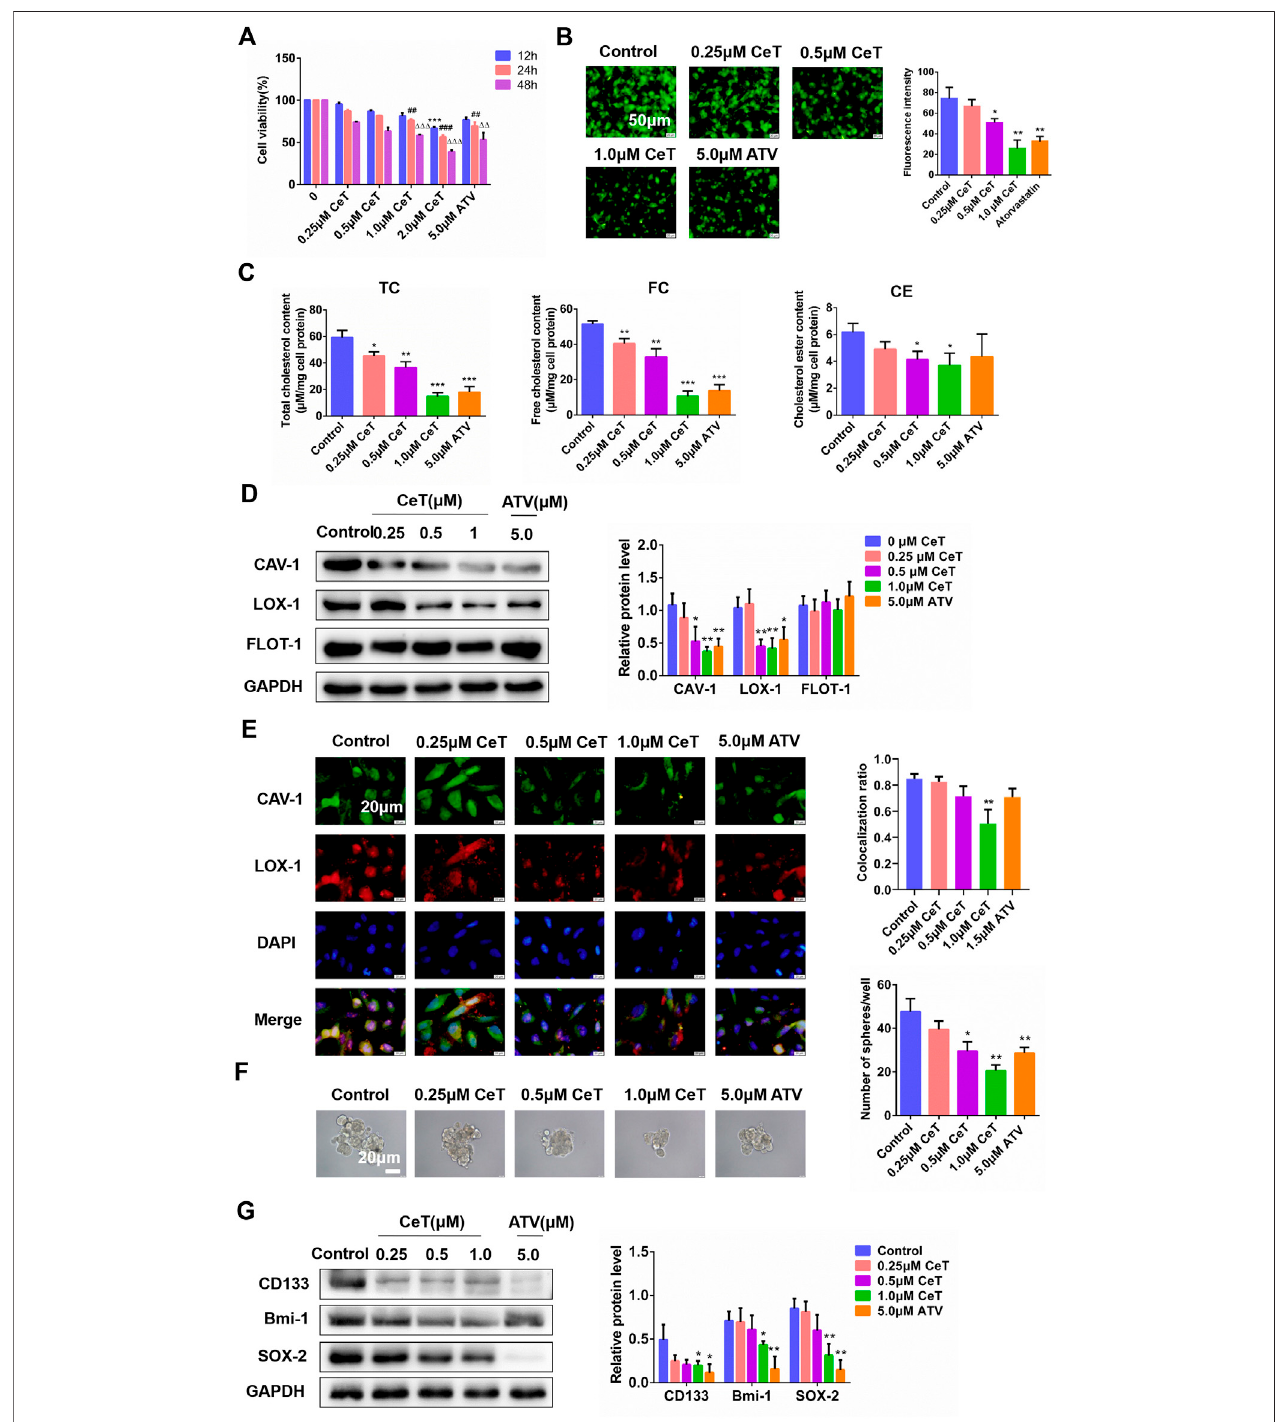
FIGURE3| Celastrolattenuatedlipidaccumulationandsuppressedstemnesscharacteristicsof786-Ocells (A) ThecytotoxicityofCeT(0.25,0.5,1.0,1.52.0 μ M) on786-OcellswasdeterminedbyCCK-8assay.12 h:*** p < 0.001vs.control.24 h: ## p < 0.01, ### p < 0.001vs.control.48 h: △△ p < 0.01, △△△ p < 0.001vs.thecontrol (B) Fluorescence microscopy of 786-O cells stained with BODIPY 493/503. Scale bar: 50 µm (C) Quanti fi cation of levels of intracellular TC, FC, and CE (D) The expression of CAV-1, LOX-1, FLOT-1 was veri fi ed by western blotting (E) The co-localization of CAV-1 (green) and LOX-1 (red) in 786-O cells was con fi rmed by immuno fl uorescencestaining.Scalebar:20 µm.ThePearson ’ scorrelationwasshowninbargraphfromthreeindependentexperiments (F) Representativeimageofthe spheroidswasphotographedand quantitative dataanalysisofspheroidsnumbers. Scalebars:20 µm (G) Theproteinlevelsofstemness markers(CD133, Bmi-1,SOX- 2) was examined by western blotting. The data were shown as the mean ± SD of three replicates. * p < 0.05, ** p < 0.01, *** p < 0.001 vs. the control.